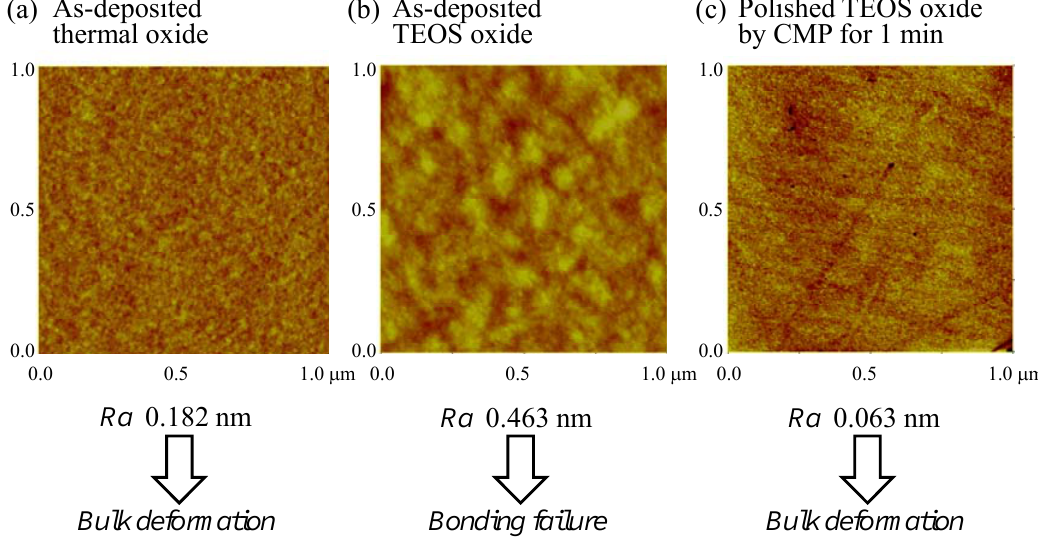
Figure 13. Cross-sectional TEM images of bonding interface between a self-assembled chip and a Si